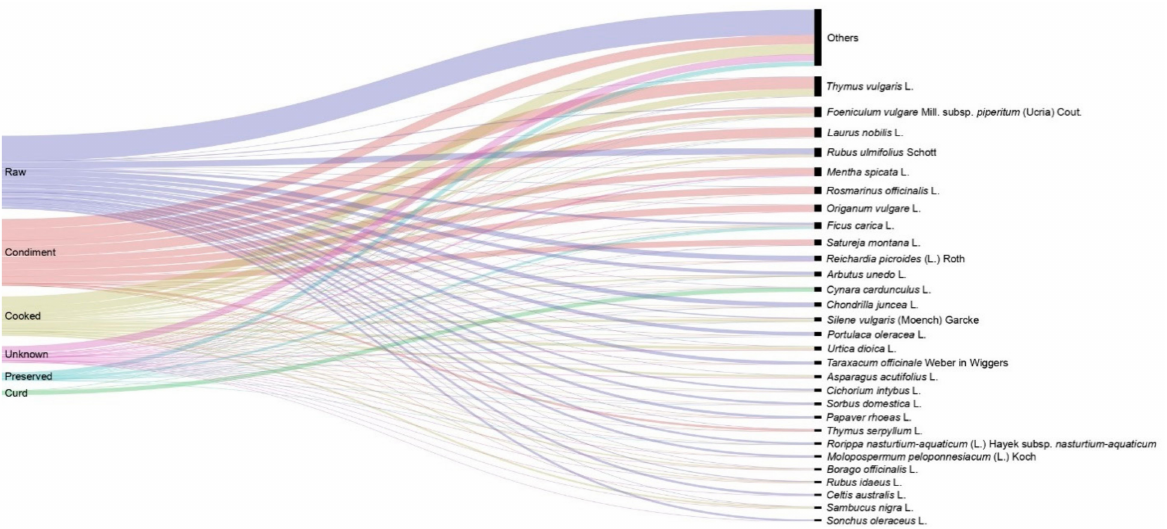
Figure 5. Modes of preparation of the most reported wild food plants in the area